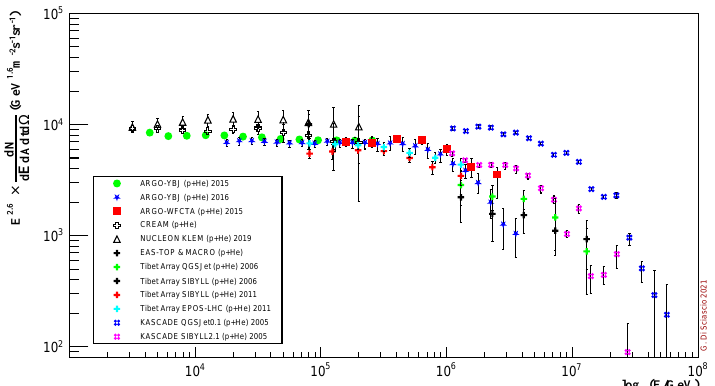
Figure 6. The energy spectra shown in Figure 5 compared with the results obtained by the KASCADE experiment by using two different interaction models to interpret data